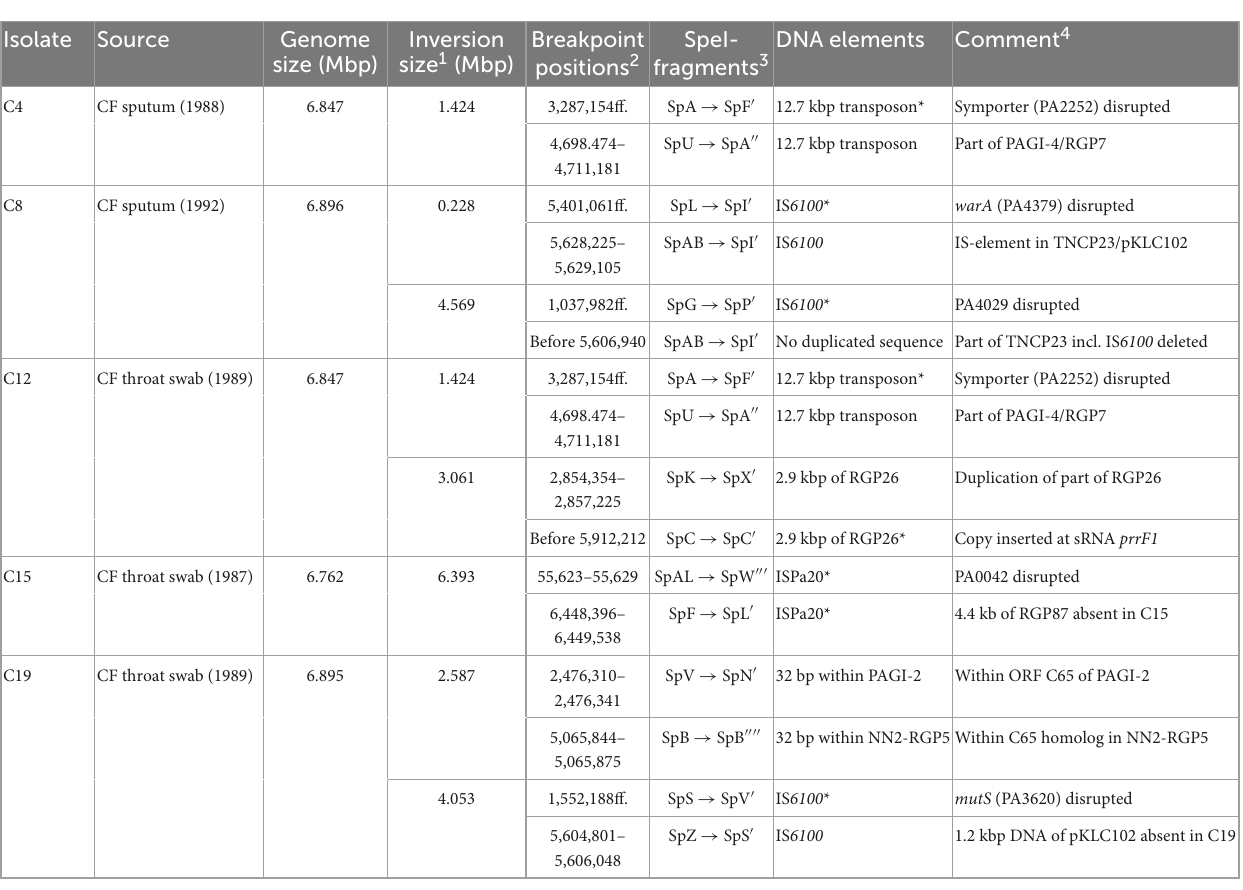
TABLE 3 Inversions in clone C isolates.